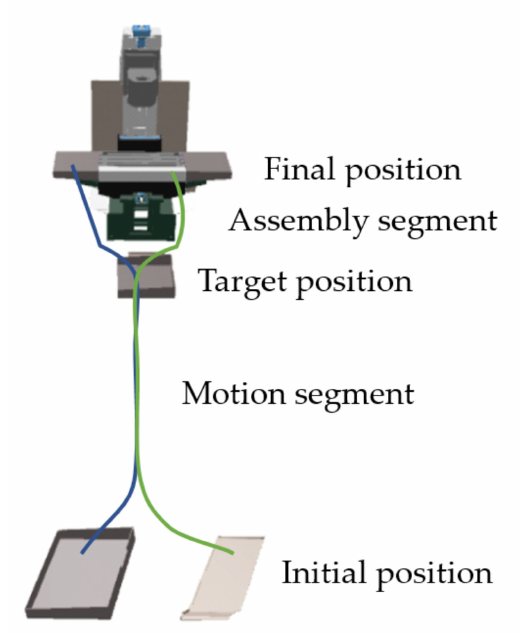
Figure 1. Segmentation of the assembly path.